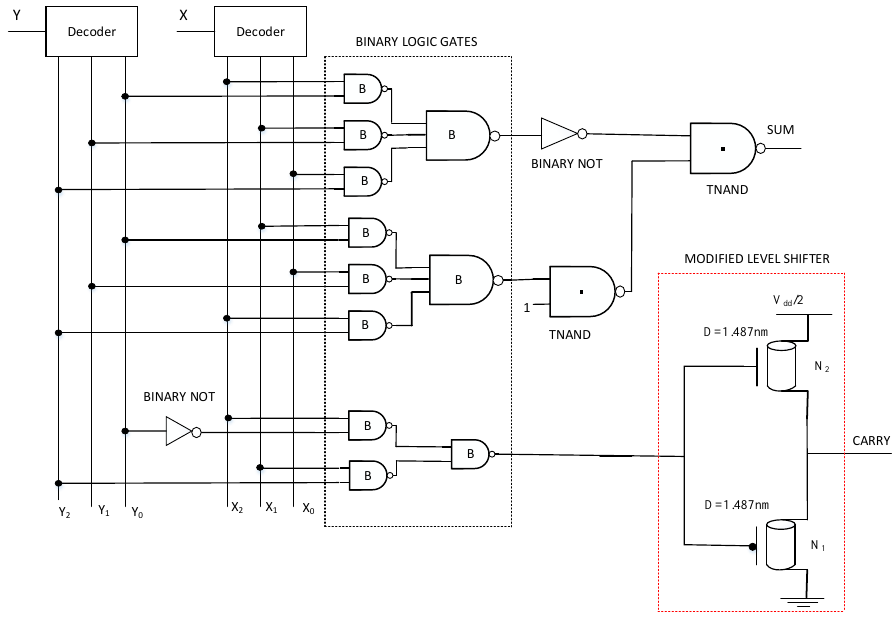
Figure 10. Circuit schematic of CNTFET-RRAM ternary half adder